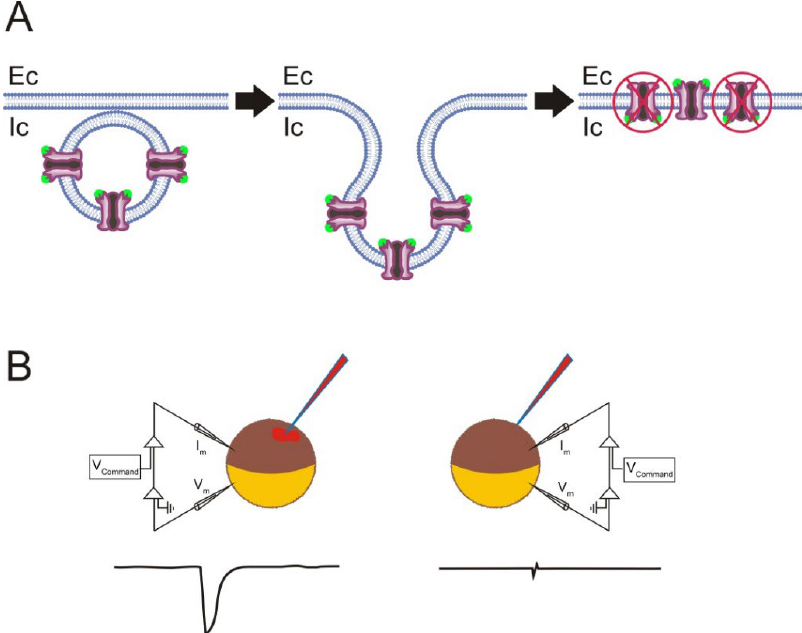
Figure 5. Protein function depends on its adequate orientation in the membrane after microtrans- plantation. ( A ) Scheme of the putative orientation in the plasma membrane of the microtransplanted nAChRs after intracellular injection of proteoliposomes bearing this protein. Note that the orientation of nAChRs in the injected proteoliposomes was mostly outside-out (left; ACh-binding sites shown as green spheres), whereas it turned to the outside-in orientation after the proteoliposome fused with the plasma membrane (right-side panel). nAChRs adopting a “wrong” orientation have been crossed out; Ec and Ic indicate extracellular and intracellular sides of the membrane, respectively. ( B ) nAChRs with an outside-in orientation lack functional activity, as evidenced by the lack of response when ACh was injected intracellularly (right panel). In contrast, focal ACh pulses over the oocyte surface, applied to nAChRs with the outside-out orientation, elicited I ACh s